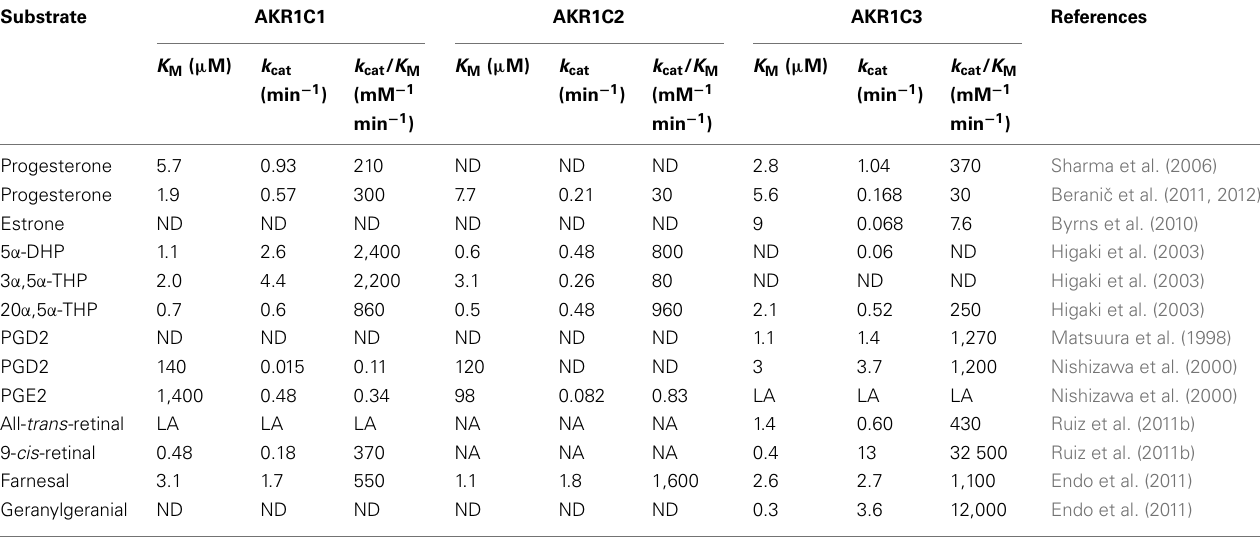
Table 4 | Kinetic parameters of theAKR1C1,AKR1C2, andAKR1C3 enzymes